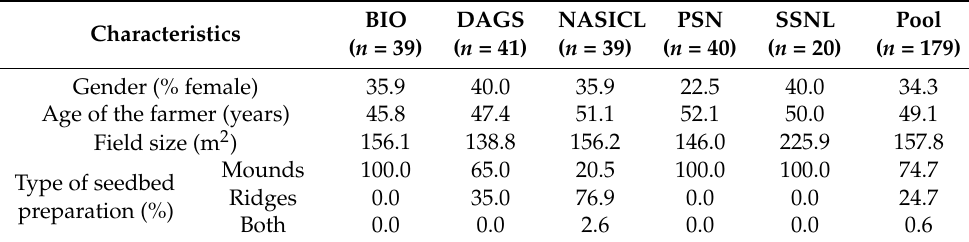
Table 1. Household and field characteristics by seed company.